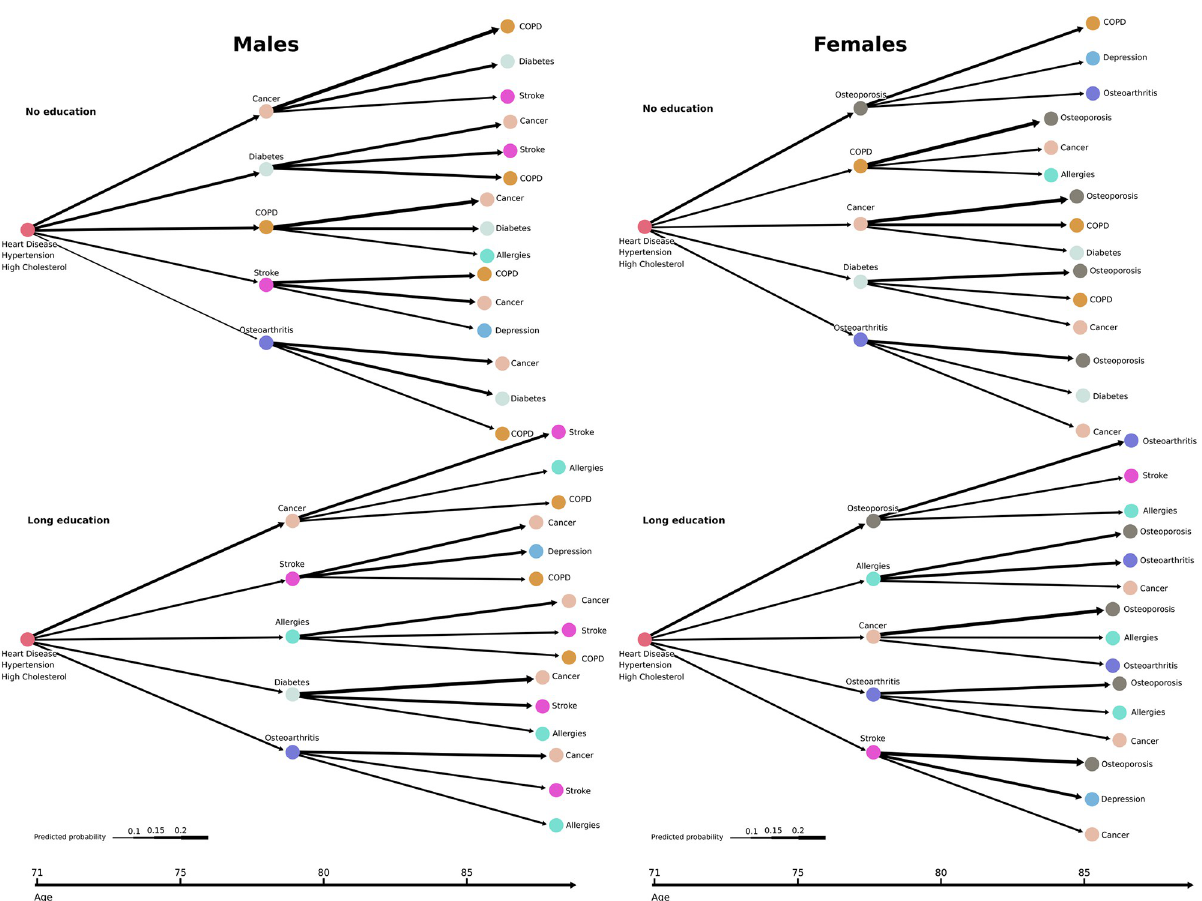
Fig 5. Sex-specific disease trajectories contrasting educational attainment. Disease trajectories starting from the most common triad of diseases for males (left) and females (right) of no education (top) and long education (bottom). Trajectories are constructed for retired individuals with calendar time and age set at the mean levels at t = 0 (70.09 years of age and 2003.37 year time, respectively). The length of the arrows corresponds to the modelled diagnosis postponement time. The width of the arrows corresponds to the modelled probability of obtaining the diagnosis next.